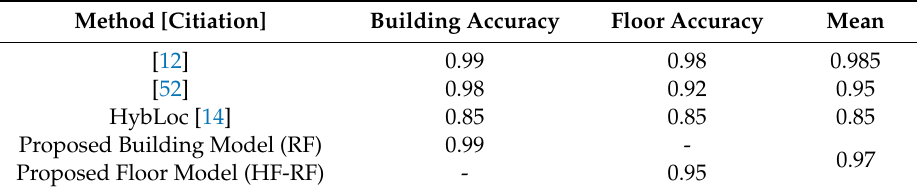
Table 12. Comparison of localization studies.